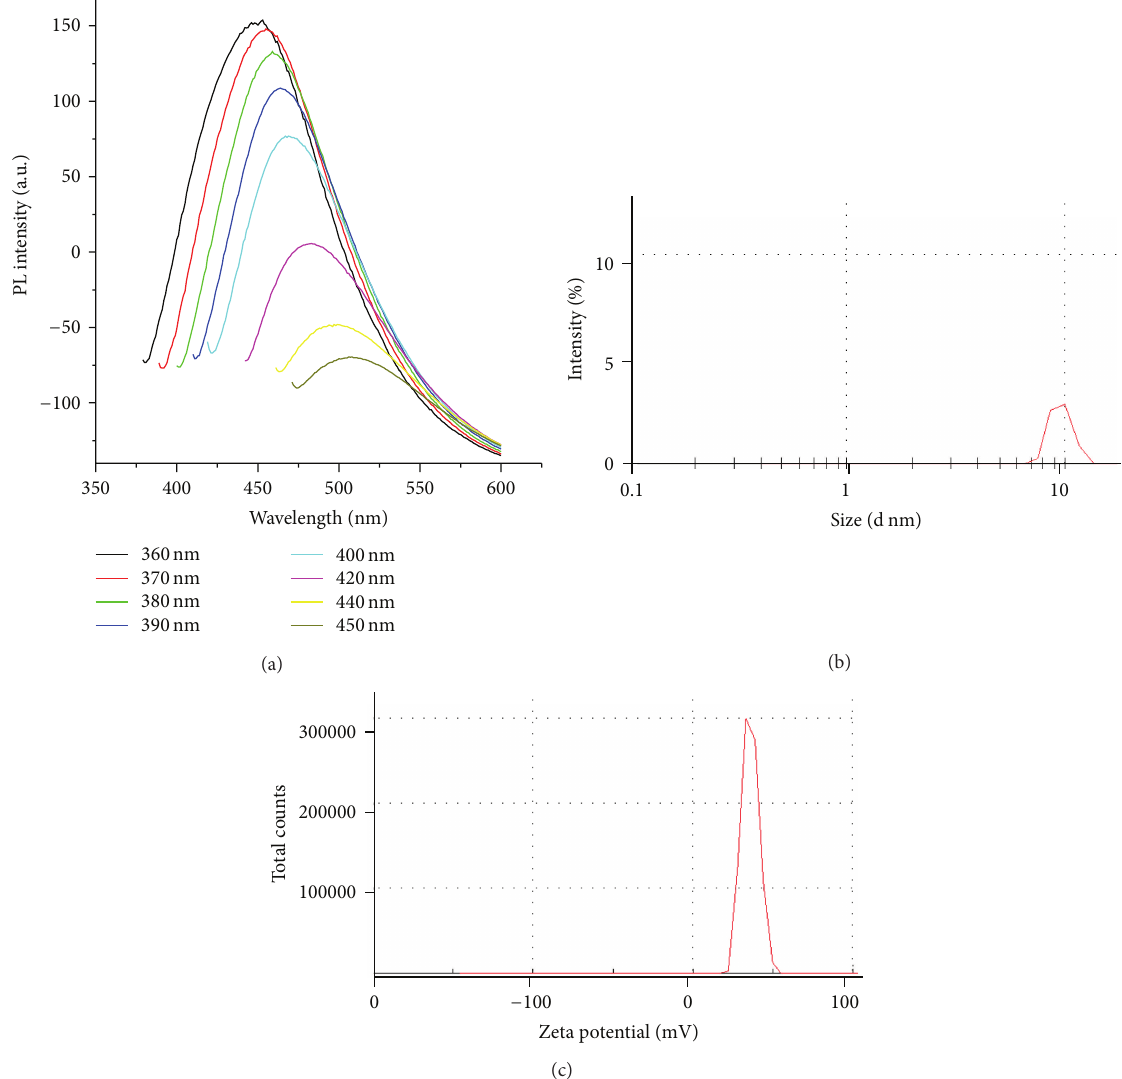
Figure 1: (a) The stacked photoluminescence (PL) spectra of CDs excited at different wavelengths (from 370 nm to 450 nm), (b) the particle size distribution graph of CDs (average size ∼ 9.7nm), and (c) zeta potential graph of CDs (ZP = 36.2 mV).